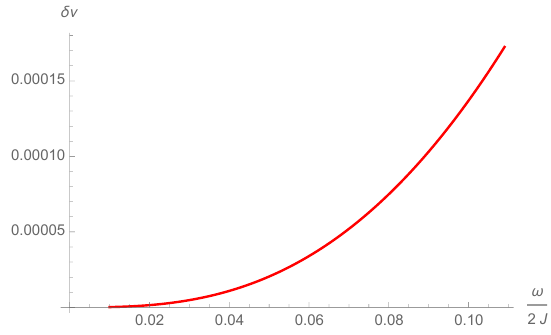
Figure 3 . Plot of the absolute difference between the allowed values of ν , where we have defined δν = ν MS − ν exact . We see that the difference is almost zero for small values of ω to the conformal